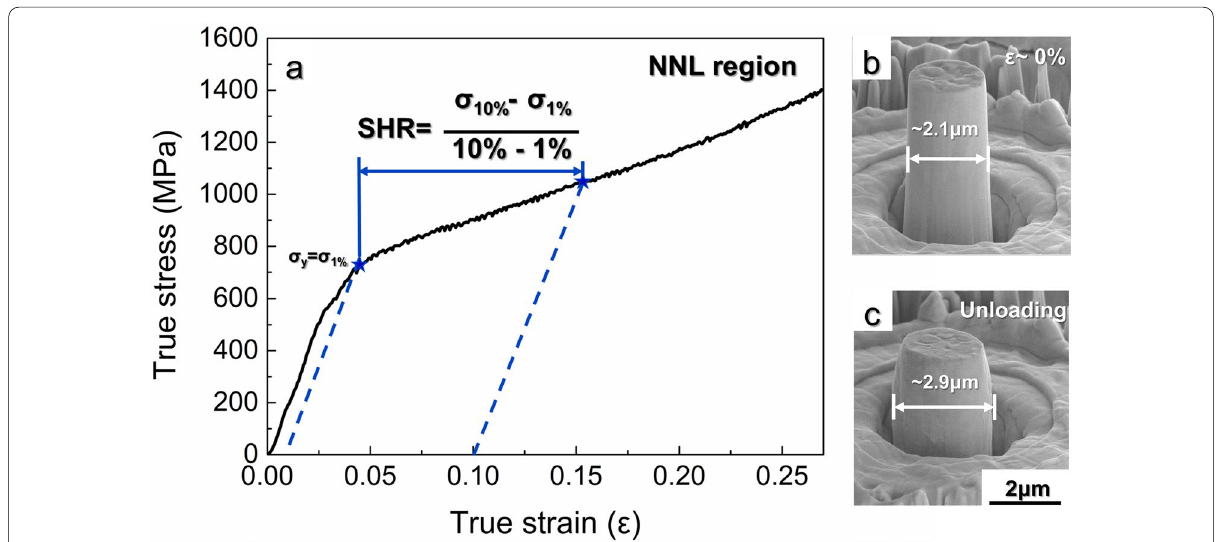
Figure 4 ( a ) True stress-strain curve of the NNL micropillar. SEM snapshots at ( b ) ε~ 0% and ( c ) unloading during